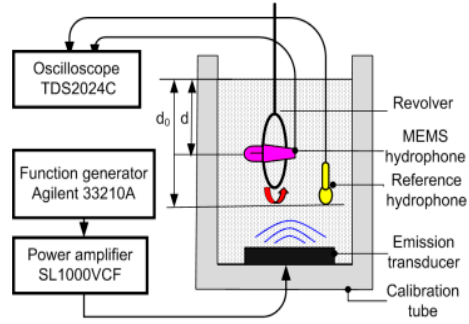
Figure 15. Schematic diagram of the test setup.